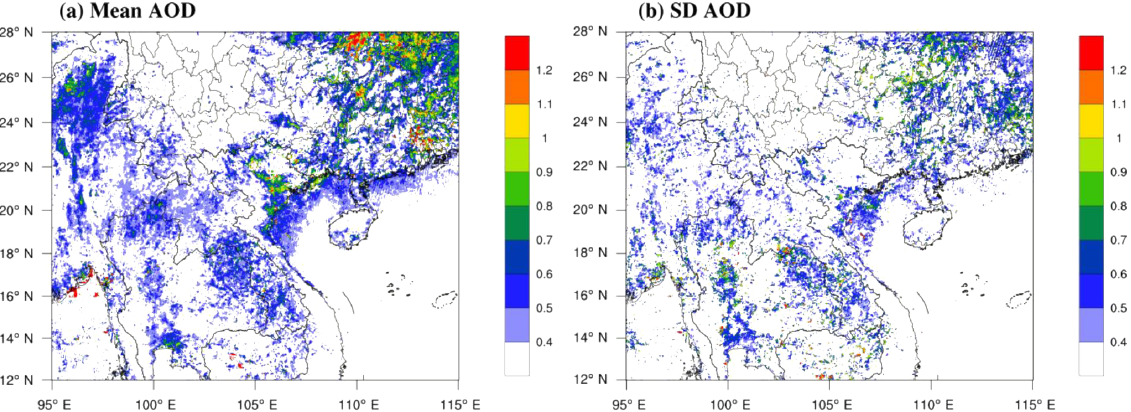
Figure 9. Average spatial distribution of the (a) mean and (b) standard deviation of daily MODIS AOD from 1 May through 30 June